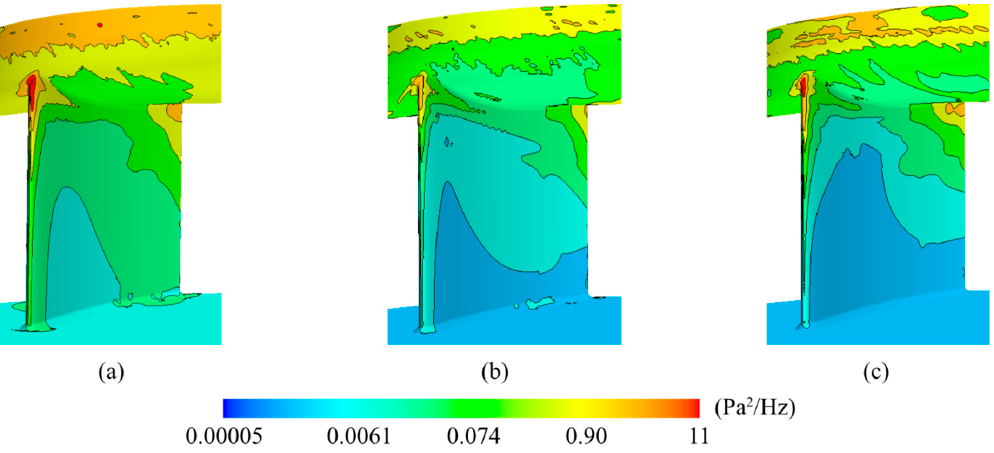
Figure 11. The PSD at 𝐵𝑃𝐹 (326.7 Hz) for wall pressure fluctuations: ( a ) Case 1, ( b ) Case 2, and ( c ) Case